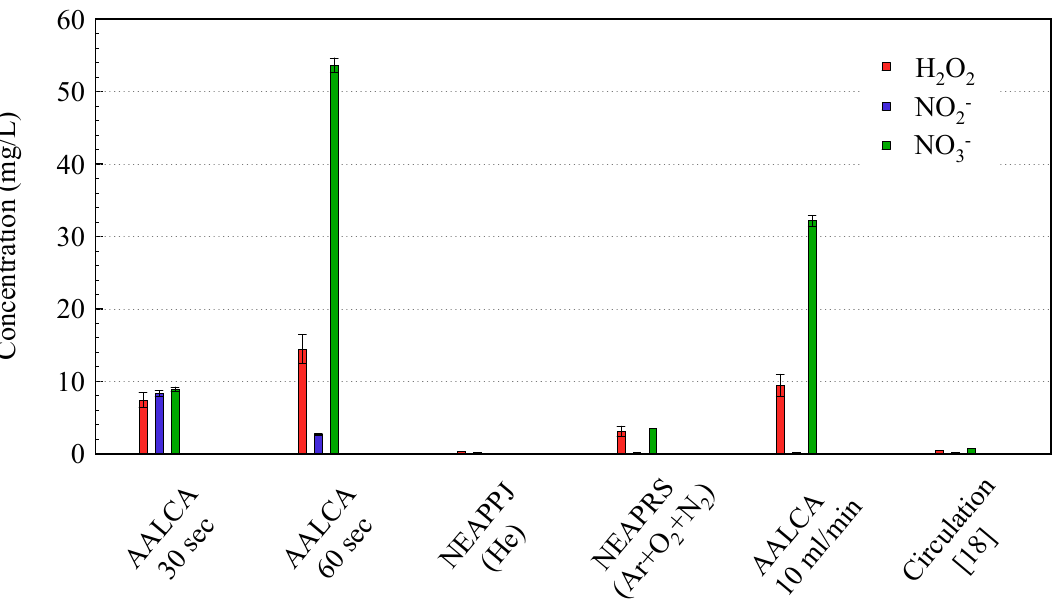
Figure 7. Comparison of concentrations of reactive oxygen and nitrogen species (RONS) in plasma-treated water (PTW) produced using treatment of 5 mL of DI water with AALCA, nonequilibrium atmospheric pressure radical source (NEAPRS), and nonequilibrium atmospheric pressure plasma jets (NEAPPJ); treatment of 10 mL/min flow of DI water with AALCA in the present work; and air plasma treatment of circulating liquid reported elsewhere [18].